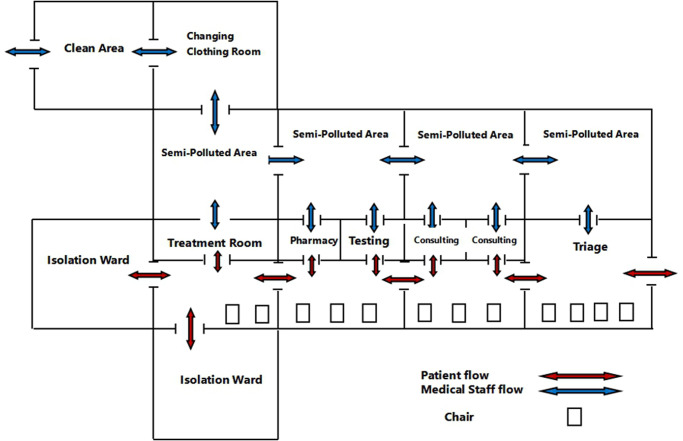
Schematic Diagram.